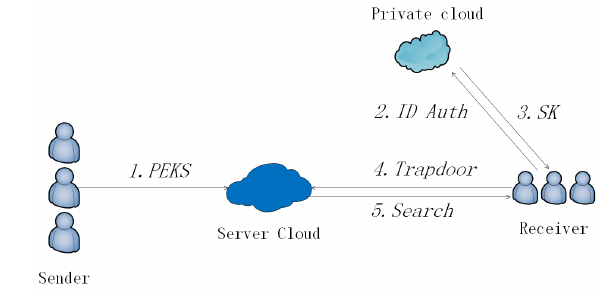
Figure 6. Multi-user PEKS (MU-PEKS).